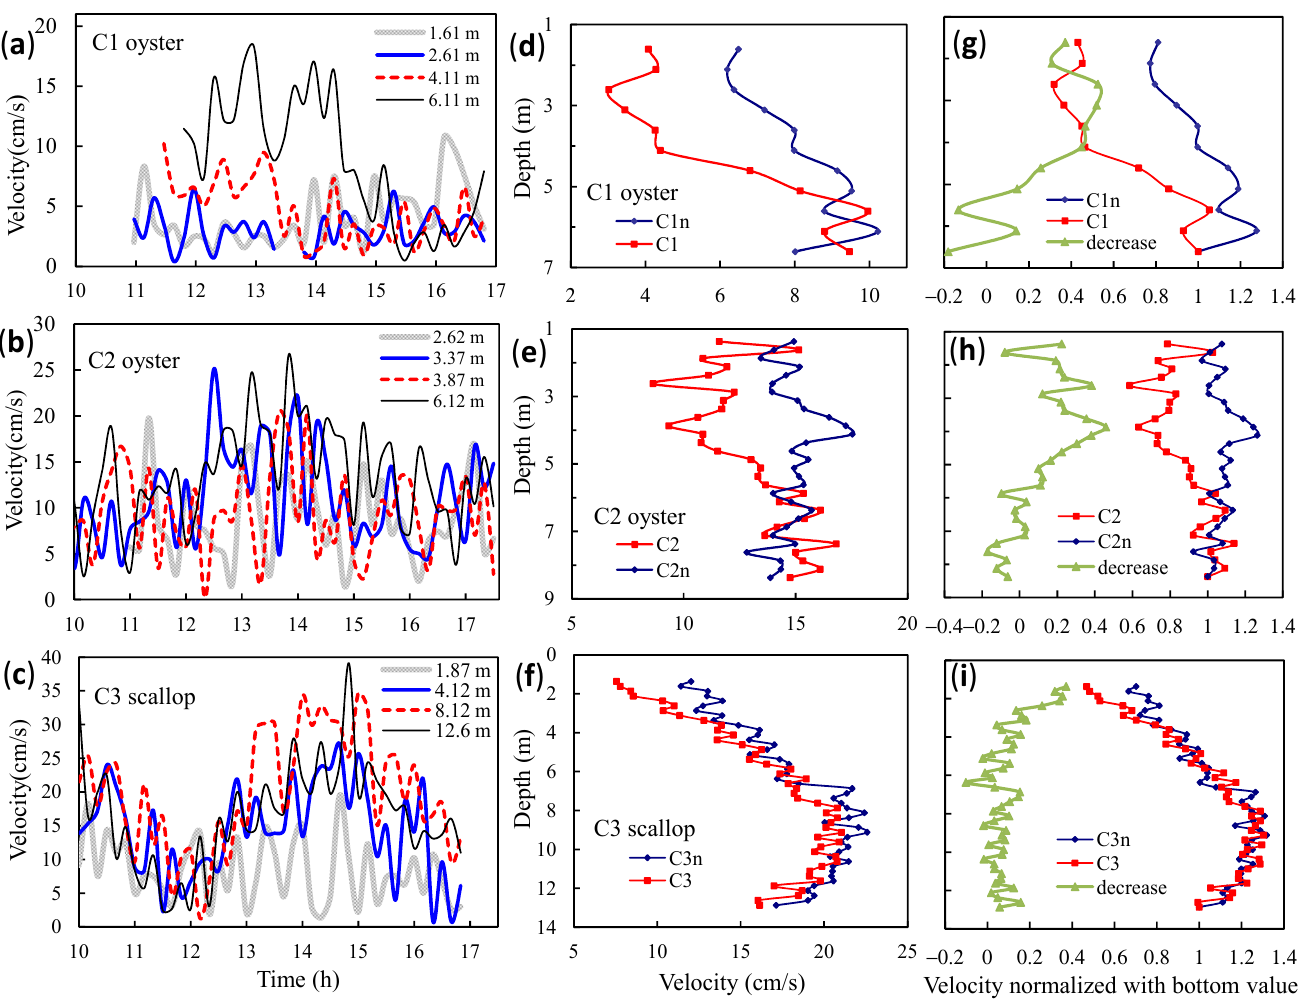
Figure 5. Vertical profiles of current velocities observed in aquaculture areas. Time series of velocities at ( a ) C1, ( b ) C2, and ( c ) C3 at different depths; time-average velocities for ( d ) C1 vs. C1n, ( e ) C2 vs. C2n, and ( f ) C3 vs. C3n; normalized values of averaged velocities and decrease rates of velocities for ( g ) C1 vs. C1n, ( h ) C2 vs. C2n, and ( i ) C3 vs. C3n. Non-aquaculture sites C1n, C2n, and C3n near culture sites C1, C2, and C3, respectively. Normalized values equal to the averaged velocities divided by near-bottom